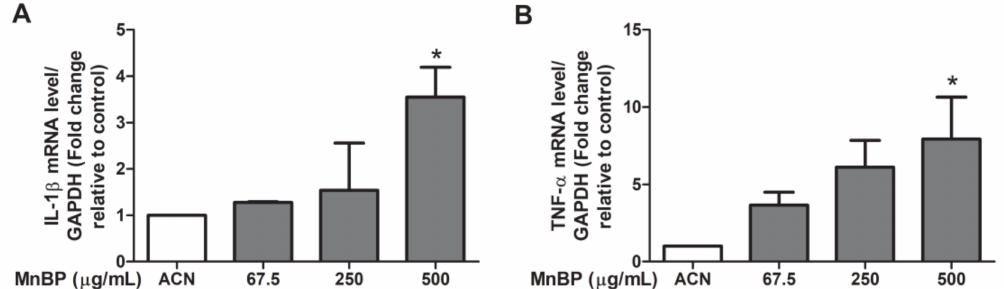
Figure 3. E ff ects of MnBP treatment on the expression of ( A ) IL-1 β and ( B ) TNF- α . The expression levels of mRNA for the interleukin-1 β (IL-1 β ) and tumor necrosis factor- α (TNF- α ) were measured using the reverse transcription quantitative polymerase chain reaction. Human granulosa cells were seeded overnight and treated with solvent control (ACN) and 67.5, 250, or 500 µ g / mL of MnBP for 24 h. The expression levels of IL-1 β and TNF- α were normalized to that of GAPDH. Data are shown as mean ± SD compared to those of the solvent control. * p <